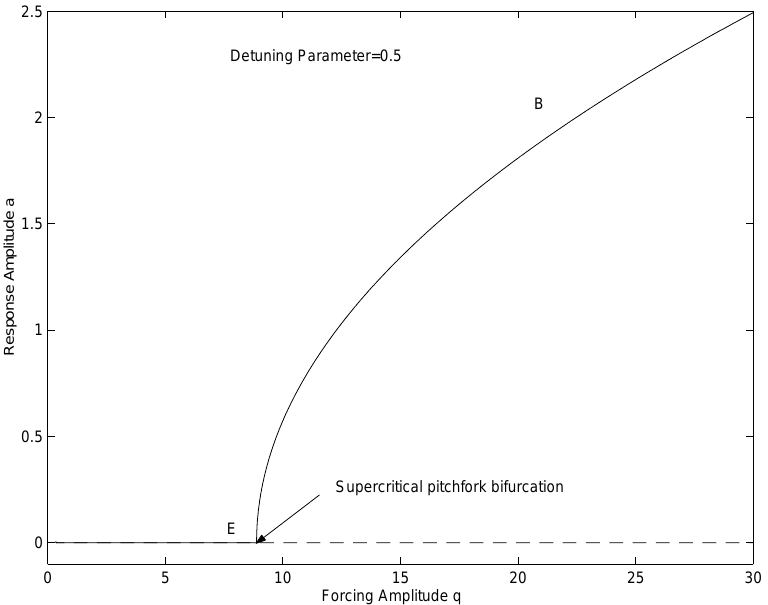
Fig. 3. Variation of the steady-state response amplitude with the forcing amplitude for positive detuning parameter.